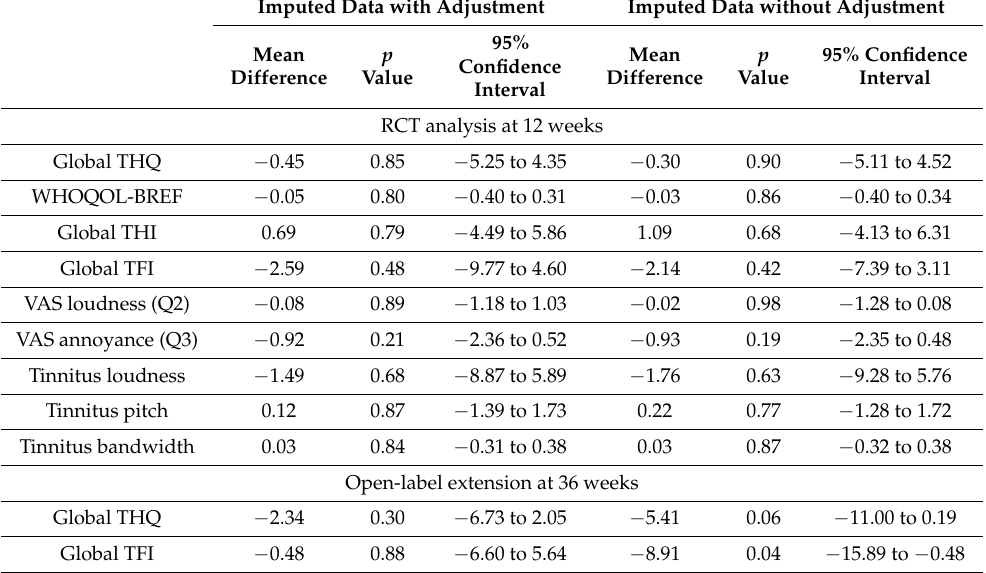
Table 7. Estimated mean differences between groups in terms of responsiveness to intervention using imputed data (visit 6—visit 2). Adjustment for randomised group, trial centre, and the factors employed in minimising participants to groups (i.e., gender, age, hearing loss and THI at the eligibility assessment) (visit 1). Tinnitus loudness in dB; Tinnitus pitch and bandwidth in kHz.